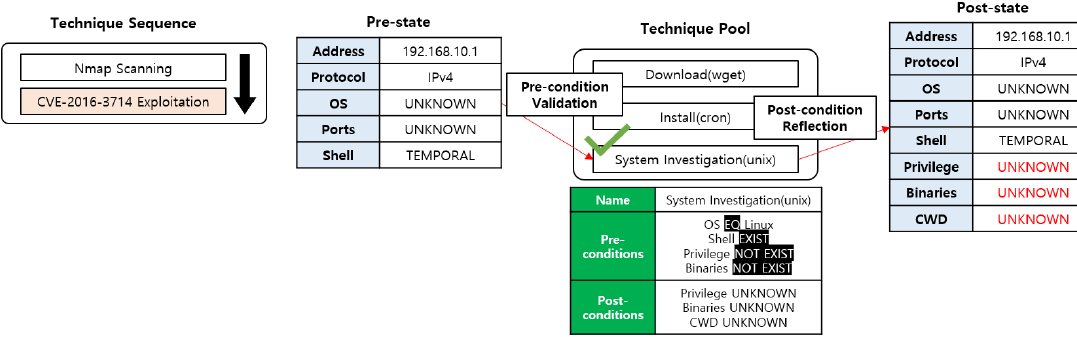
Figure 4. The example of the process of scenario generation: system investigation